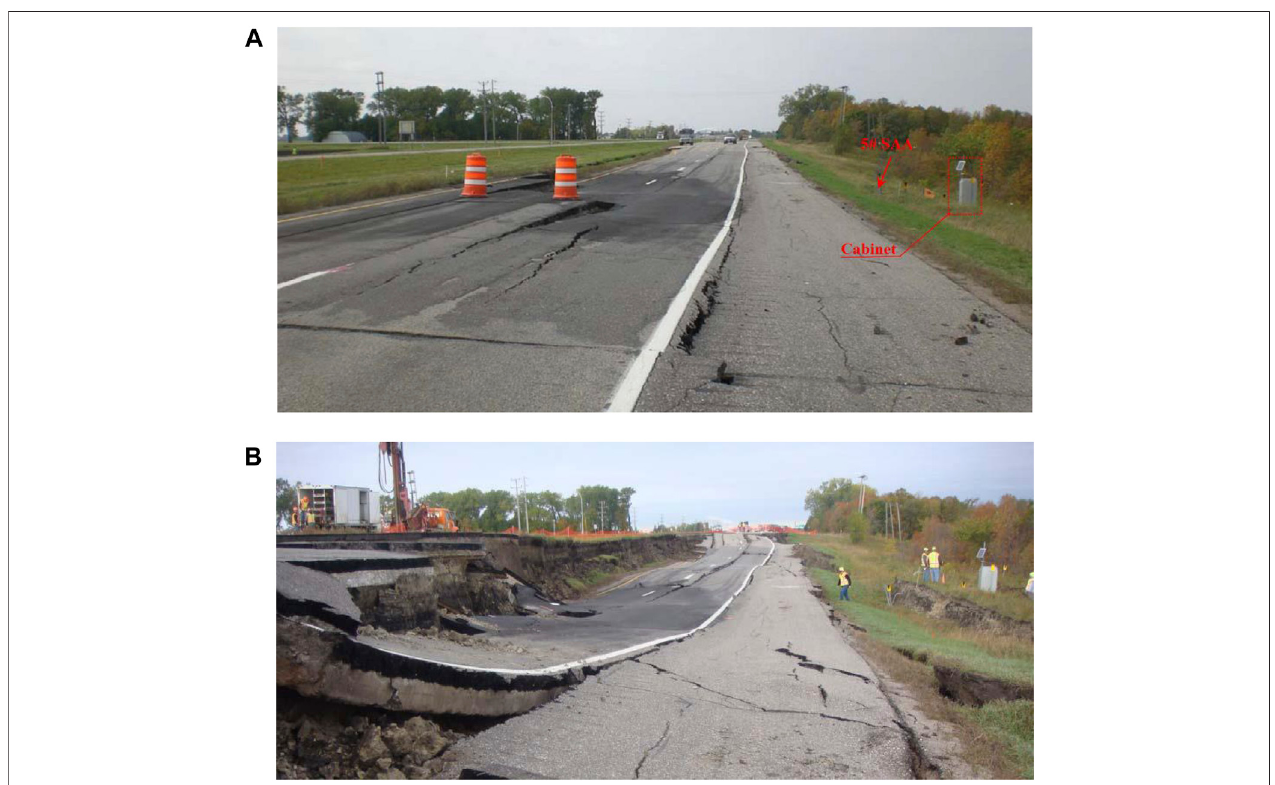
FIGURE 4 | Macroscopic deformation (A) before sliding and (B) after sliding. The 5# SAA and 4# SAA are located about 4.57 m upward and downward from the cabinet, respectively (Modi fi ed from Dasenbrock, 2010.)